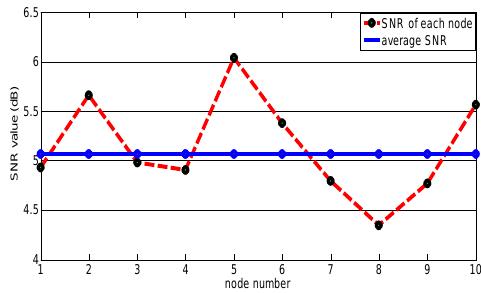
Figure 6. SNR of each node (red) and threshold (blue) of network.